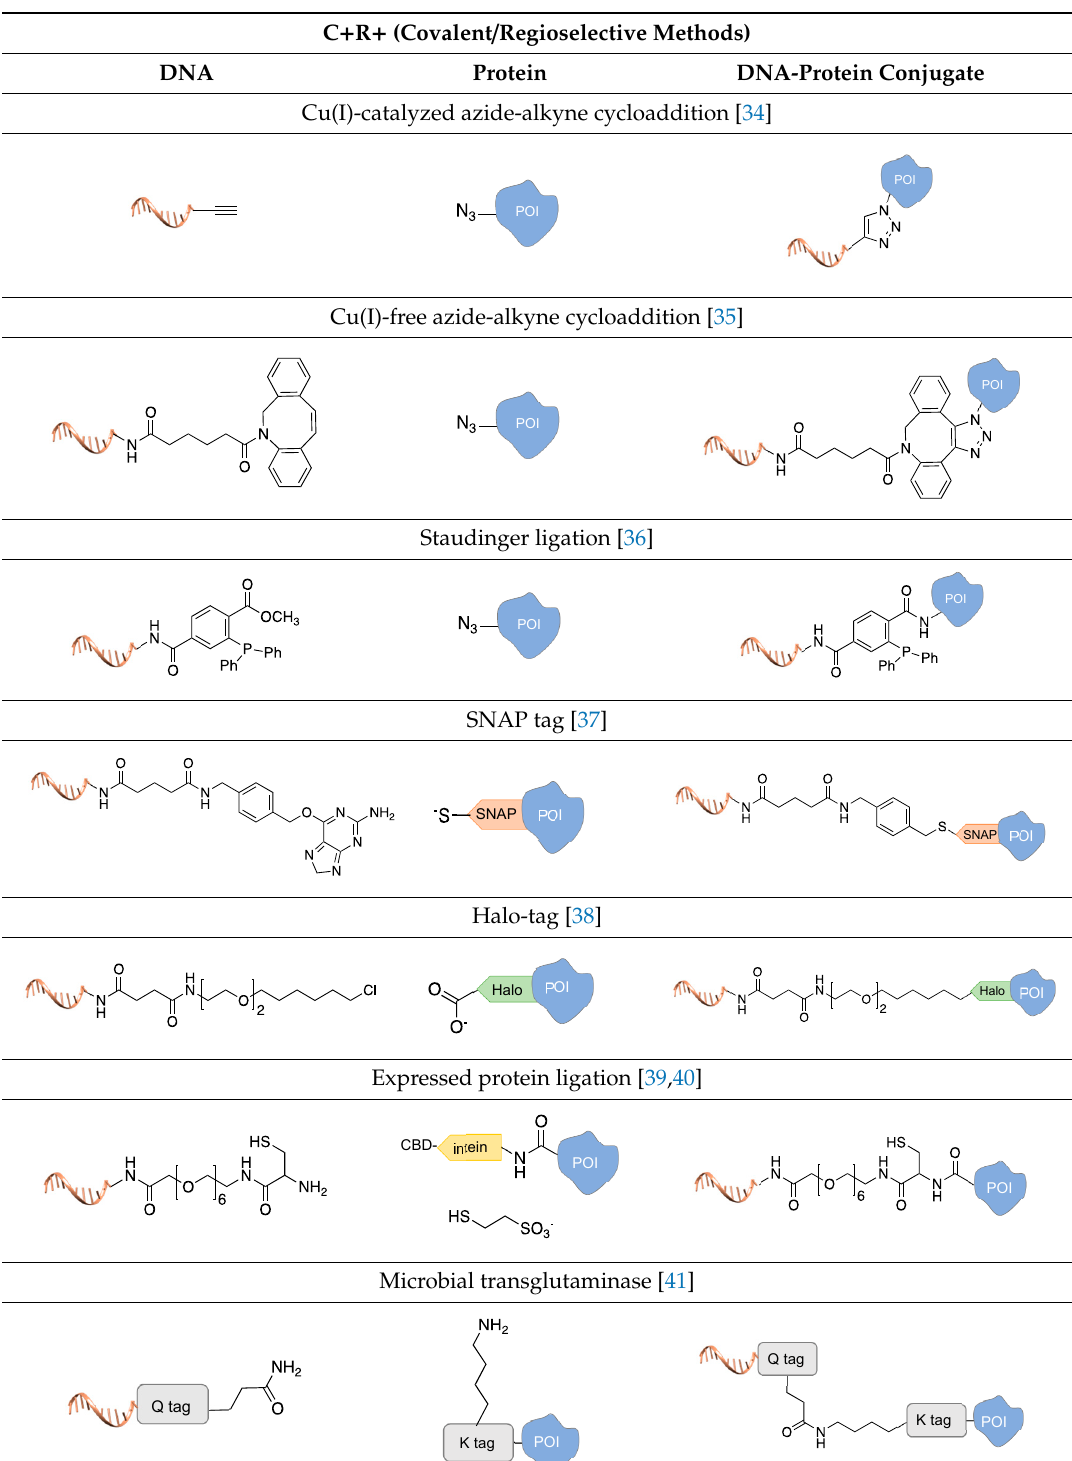
Table 2. Representative covalent and regioselective (C+R+) DNA-protein conjugation methods.